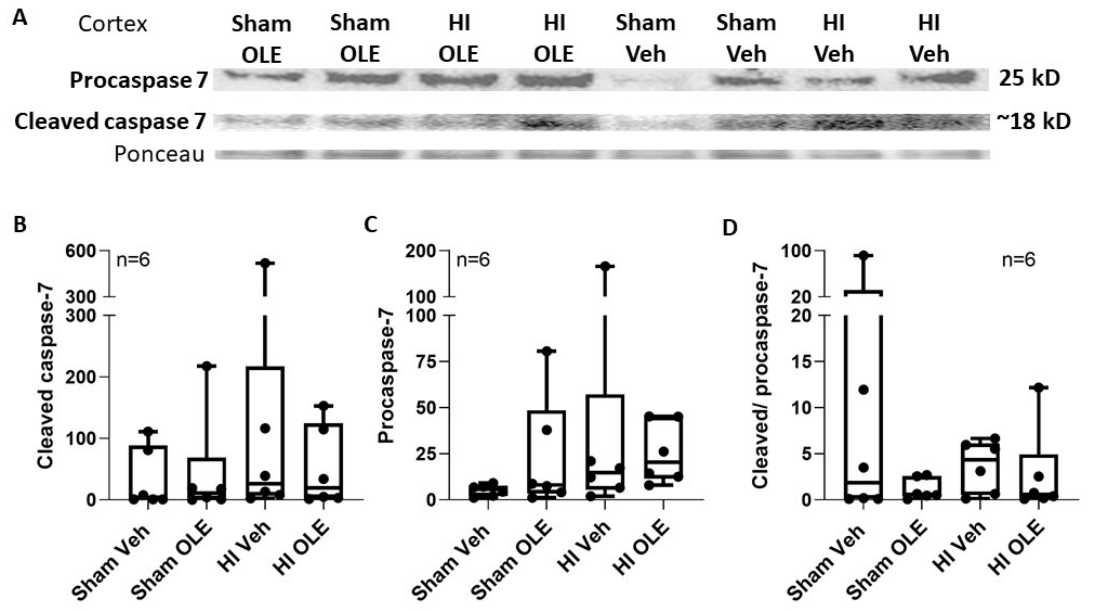
Figure 14. Caspase-7 immunoreactivity in somatosensory cortex 29 h after hypoxia-ischemia (HI) or sham procedure with hypothermia. Piglets also received oleuropein (OLE) or vehicle (veh). ( A ) Western blots did not show differences between groups for cleaved caspase-7 ( p = 0.466, B ), procaspase-7 ( p = 0.082, C ), or the cleaved-to-procaspase-7 ratio ( p = 0.0631, D ). The box plot whiskers show the 5th and 95th percentiles.